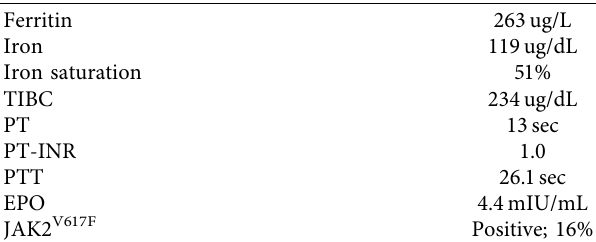
Table 2: Hematology workup.